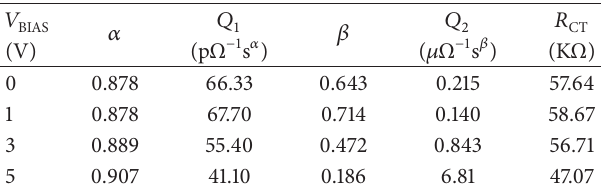
Table1:Bestfittingvaluesofparametersin(2)forpuregelatinbased devices.